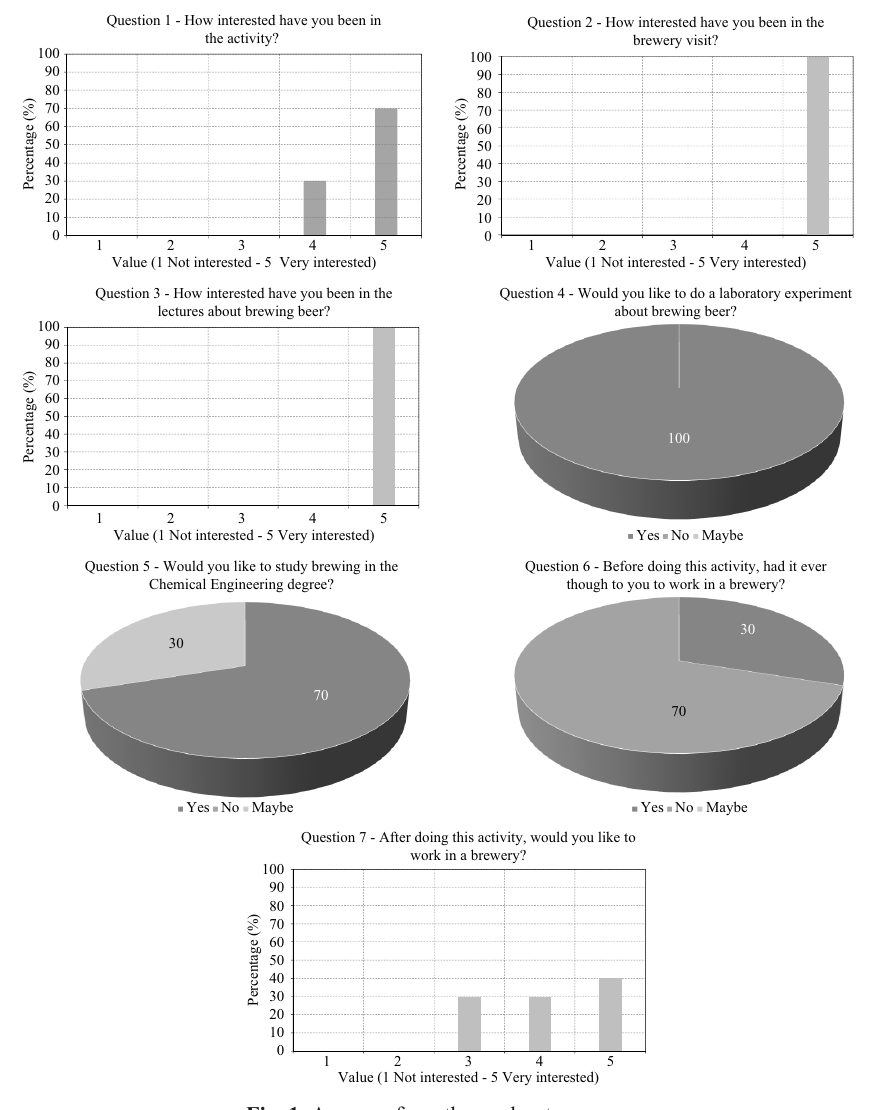
Fig. 1. Answers from the exploratory